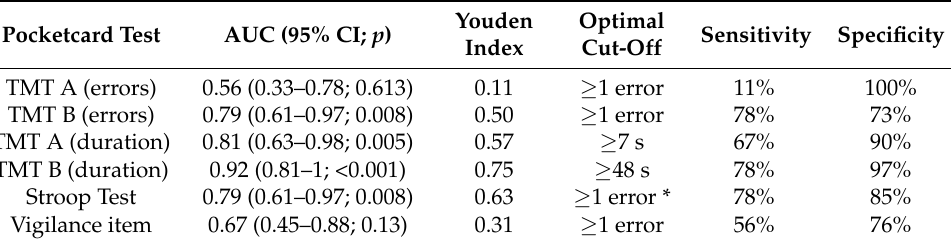
Table 2. Screening test performance regarding pathological impairment of executive function detected through EpiTrack ® ( n =